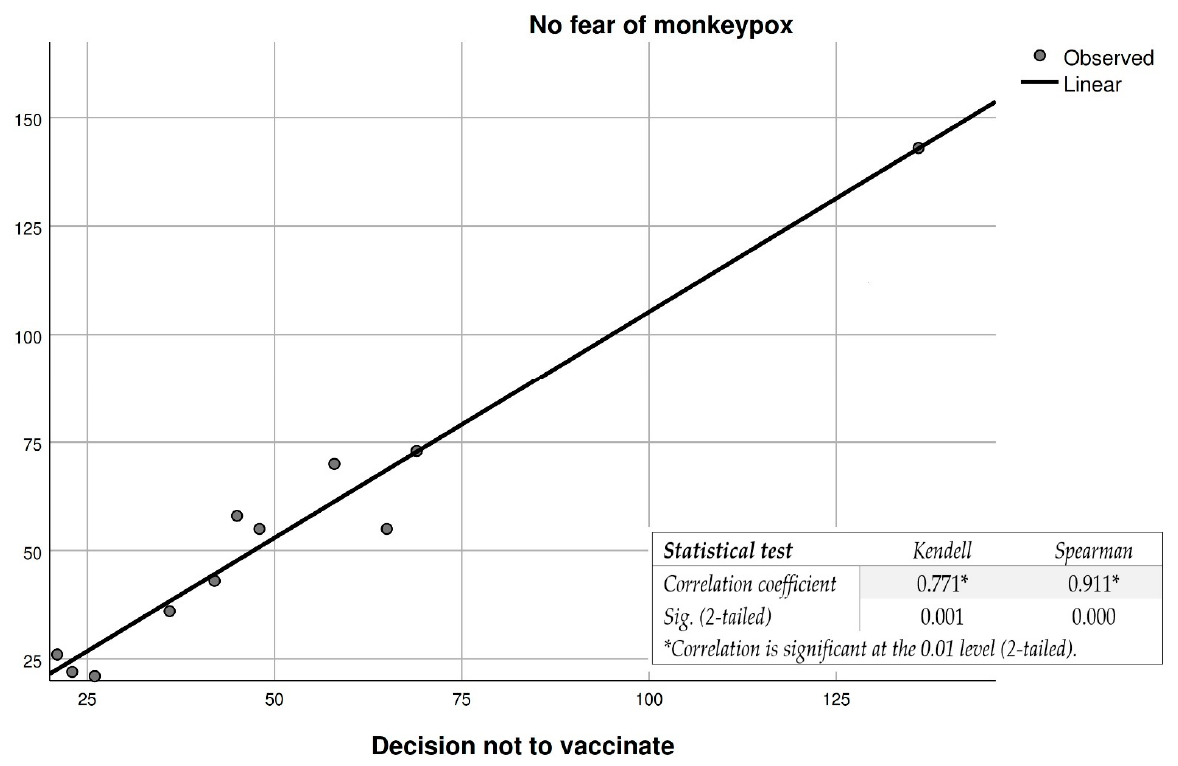
Figure 2. Correlation between fear of the monkeypox disease and the participants’ decision not to vaccinate against the disease. * For a correlation to be very strong, the correlation coefficient must be as close as possible to 1, and sig. as close as possible to 0. Regarding the determination of the correlation between people who chose to vac- cinate against COVID-19 and those who accept vaccination against monkeypox, Figure 3 shows that both the Kendell and Spearman correlation indices show a very good degree of association (correlation is strong). The COVID-19 vaccination indicator of individuals can be taken into account in the case of large-scale vaccination against monkeypox. Par- ticipants vaccinated against COVID-19 show a high degree of acceptance of vaccination against monkeypox as a result of their confidence in the vaccines.